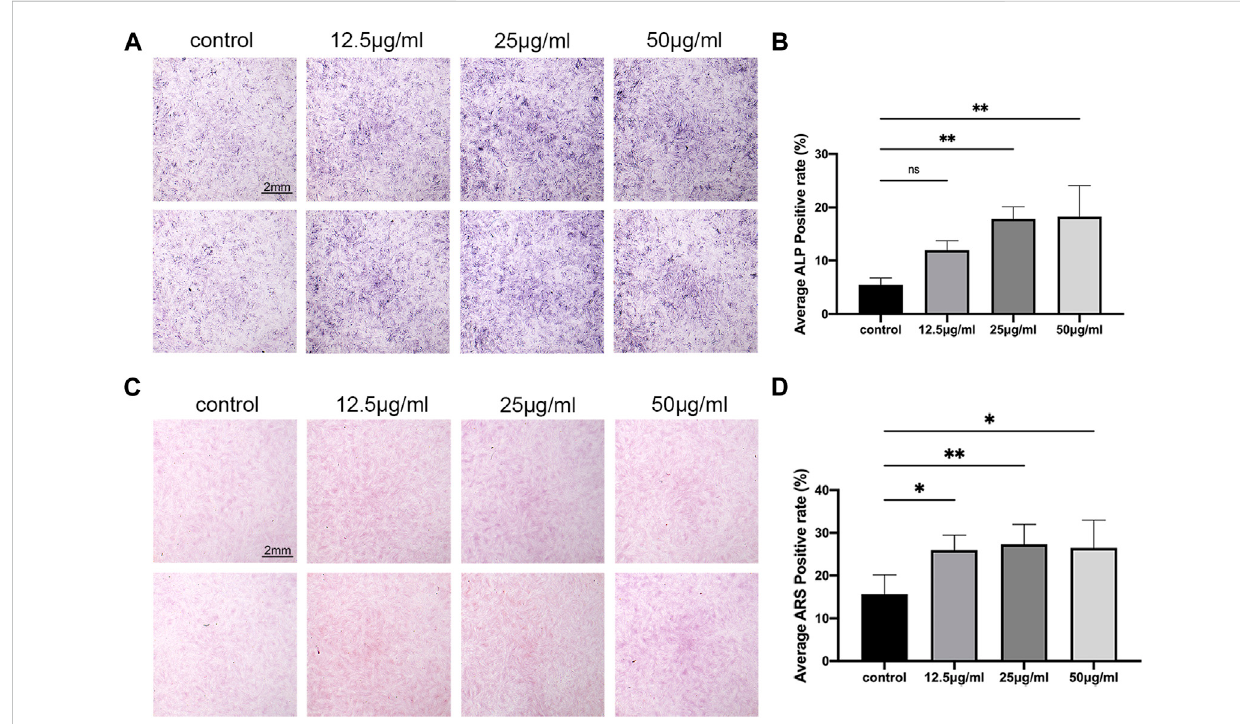
FIGURE 2 The effect of LPK on osteogenic-induced C3H10 cells in-vitro . (A) ALP staining of C3H10 cells treated with different concentrations of LPK. (B) Quantitative analysis of ALP positive area. The positive rate of ALP was expressed by the detection value under the same condition. Compared to the control, a signi fi cant difference was de fi ned at p < 0.05 (*); p < 0.005 (**); p < 0.0005 (***); ns: the difference was not statistically signi fi cant. (C) ARS staining of C3H10 cells treated with different concentrations of LPK. (D) Quantitative analysis of the positive area, compared to the control; the positive rates were considered signi fi cantly different at p < 0.05 (*); p < 0.005